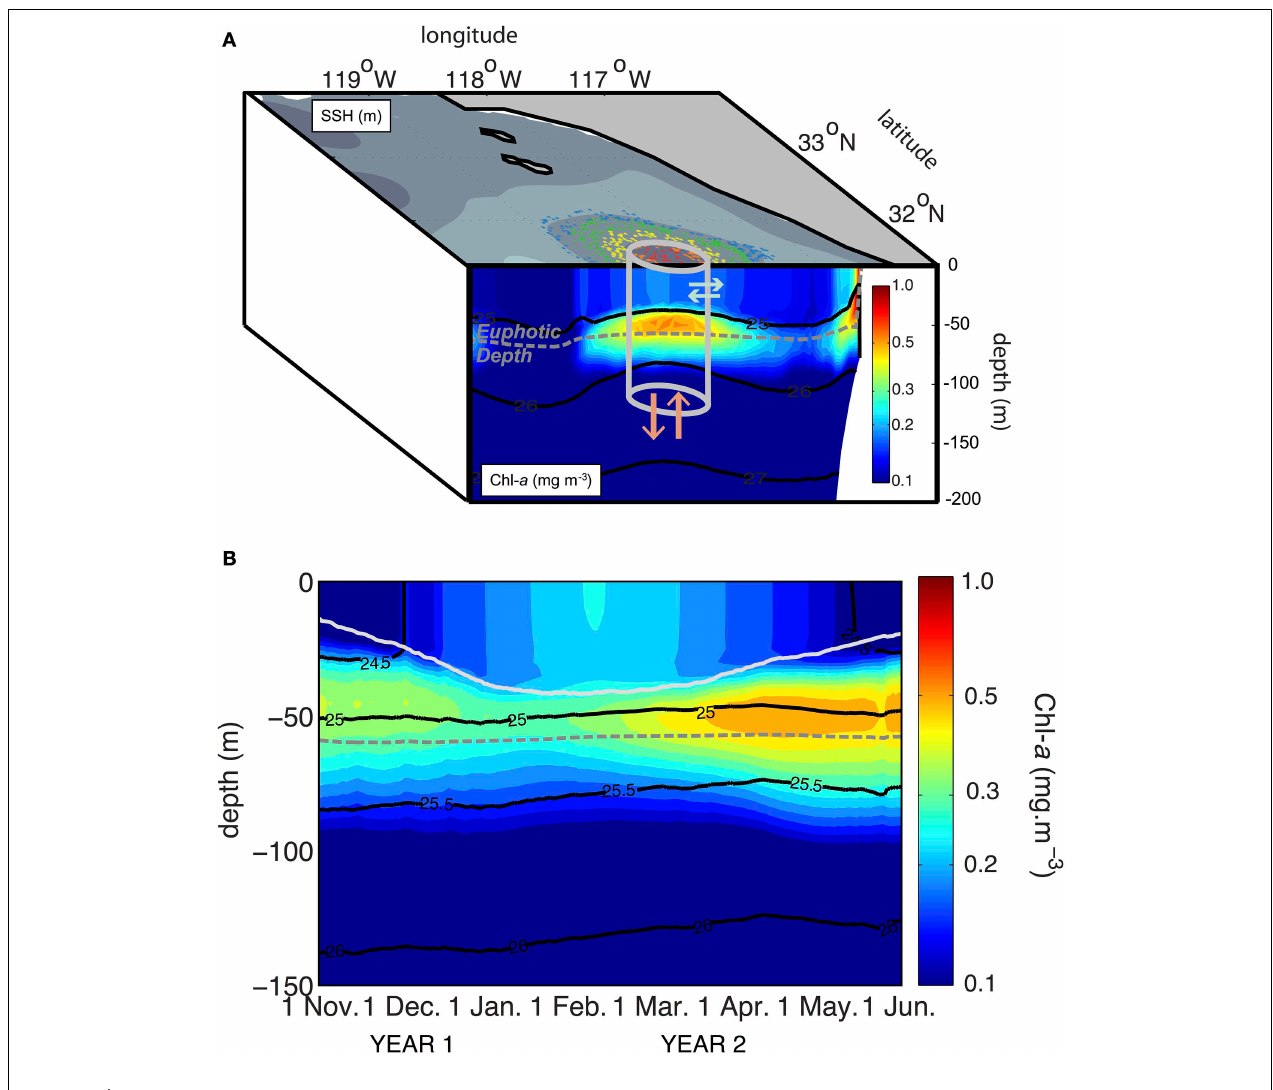
FIGURE 8 | Biological response in an eddy of the California Current upwelling system. (A) Schematic of the dynamical box (the eddy core) defined by the red and orange pools of particles (see Figure 7C ). The eddy core contains an enhanced subsurface chlorophyll-a maximum. Within this box, at each time step, vertical exchanges (orange arrows) for example